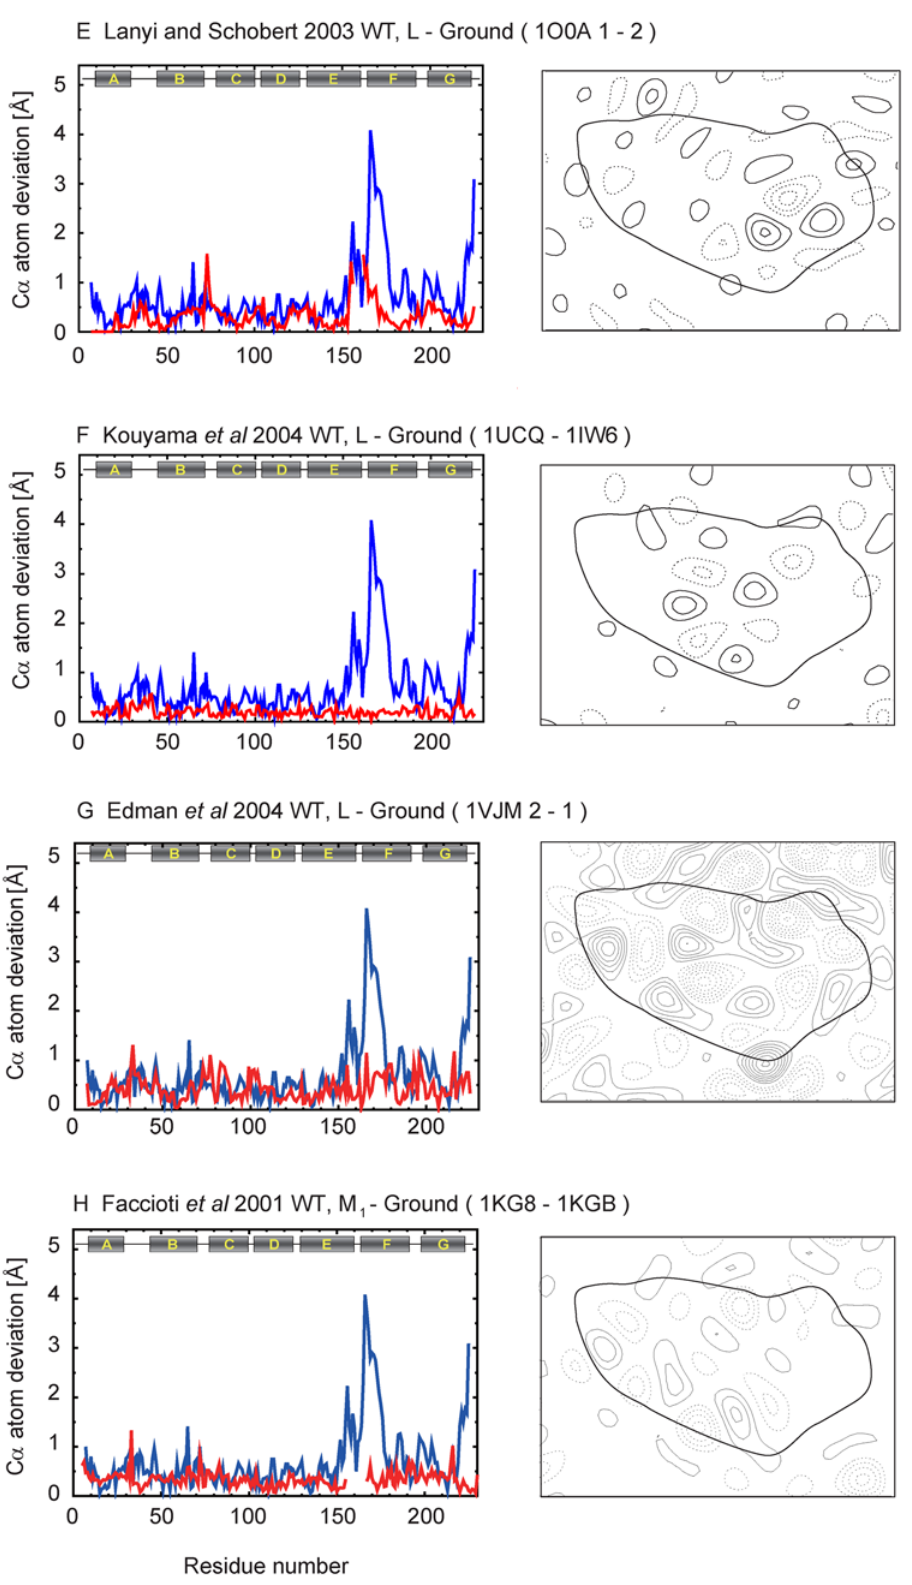
Figure 6. C a atom deviation plots and difference maps between intermediate and ground states calculated at 7 A˚ (continued).